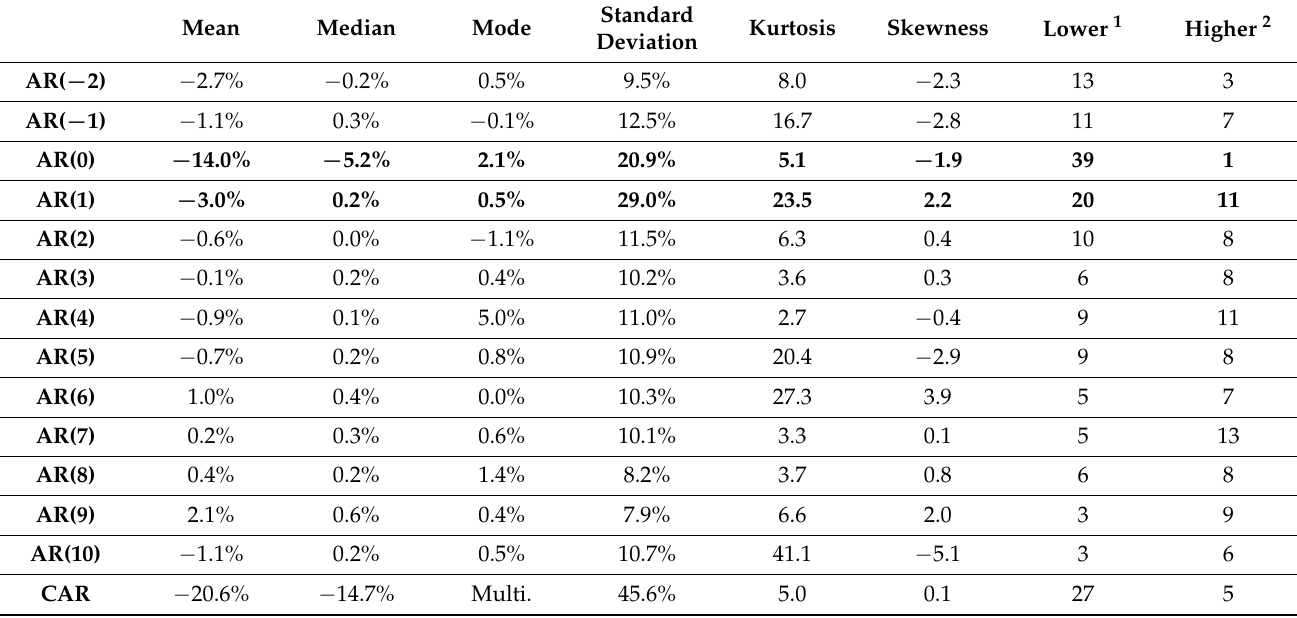
Table 5. Selected statistics determined based on all observations (Option 1).